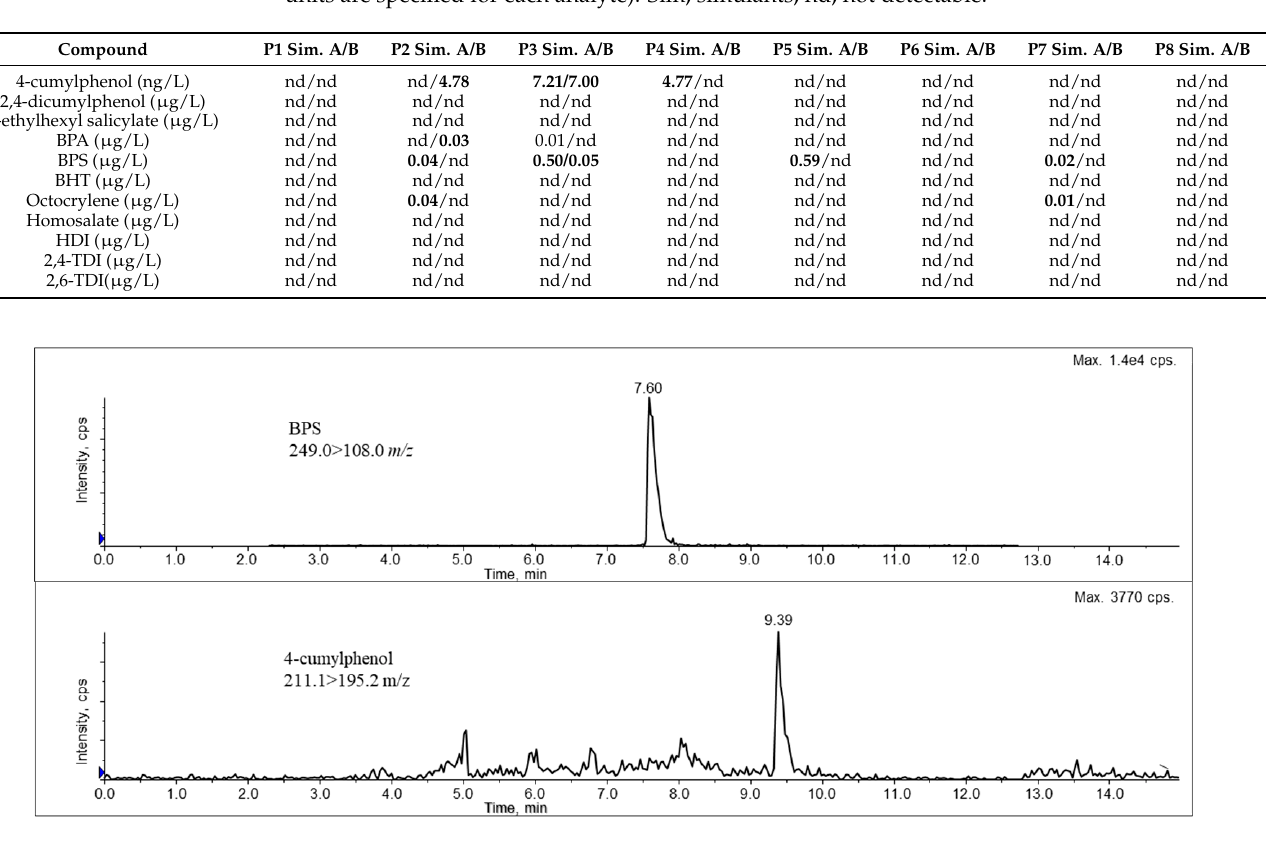
Figure 1. Chromatographic separation of BPS and 4-cumylphenol in sample P3 treated with simulant B (20% ethanol).